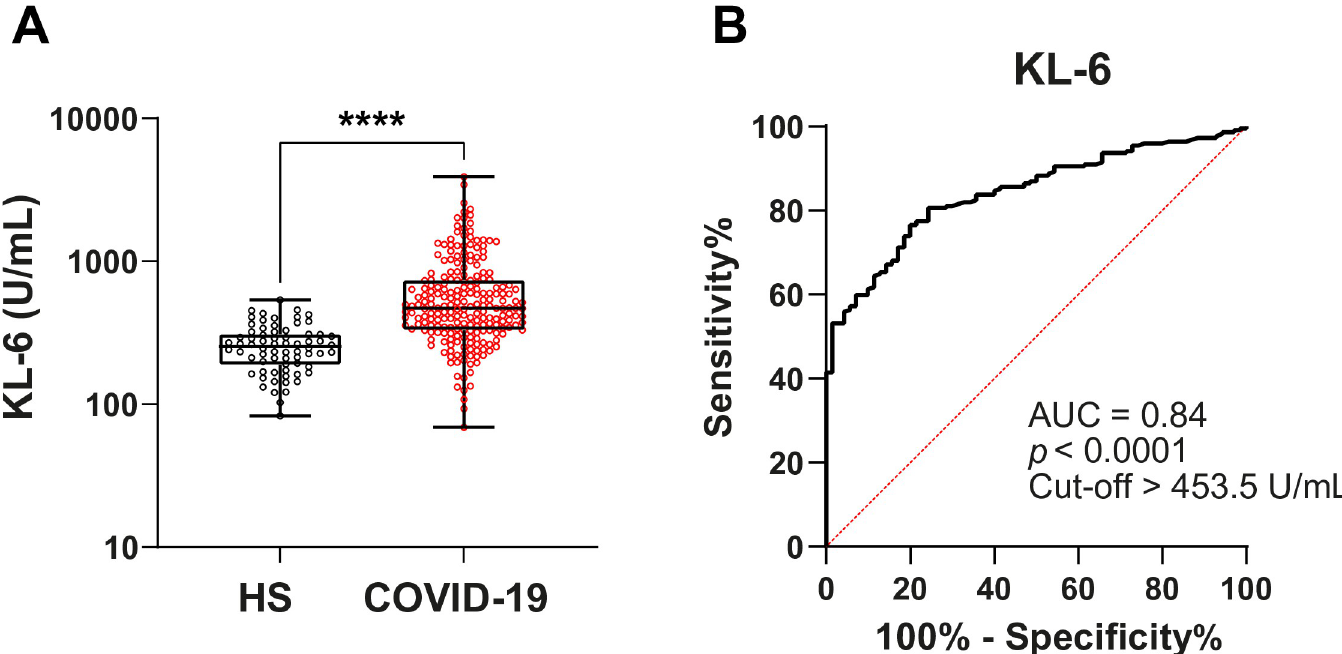
Fig 1. Capacity of KL-6 to discriminate between COVID-19 patients and HS. ( A ) KL-6 level in HS and in COVID-19 patients. Data are non-normally distributed and are analyzed using a non-parametric two-tailed Mann-Whitney test. ���� P < 0.00001. ( B ) ROC curve analysis to determine the level of KL-6 which will enable to discriminate COVID-19 patients and our reference population (HS).